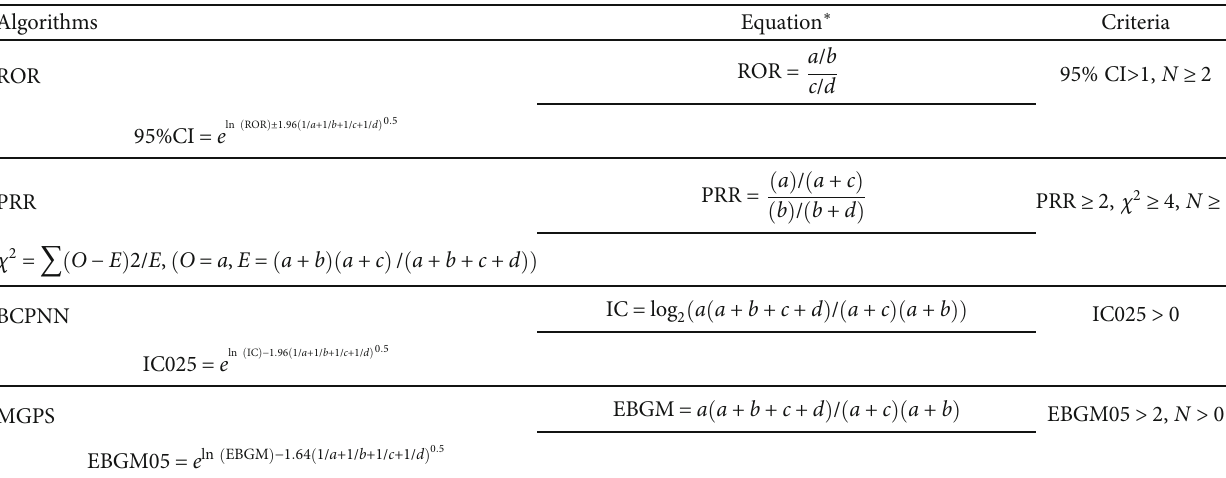
Table 2: Summary of major algorithms used for signal